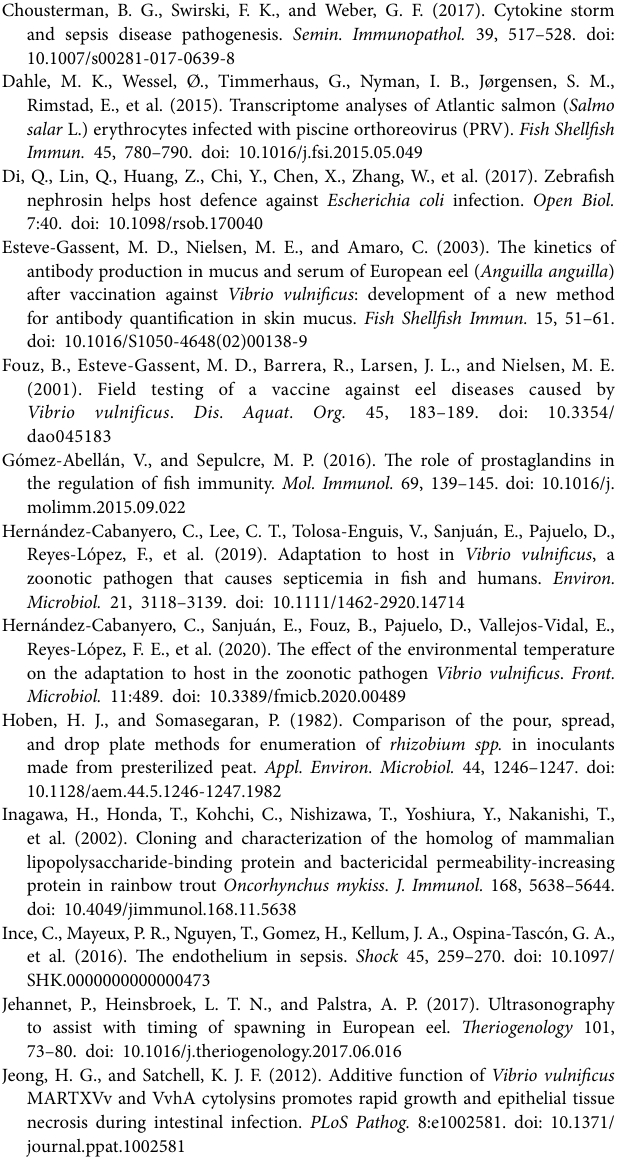
Supplementary Figure S1 | Experimental design used in this study and comparisons performed in the transcriptomic analysis. For specific information about procedures see Materials and methods